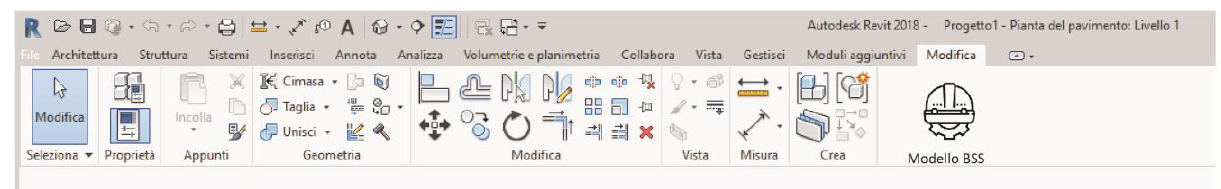
Figure 4. The historic building presents only one way of exodus. In the event that this cannot be used for various reasons such as the breaking of the door or the execution of work activities on the ground floor. The staff will use the stairs provided with the scaffolding to exit and reach the collection point.